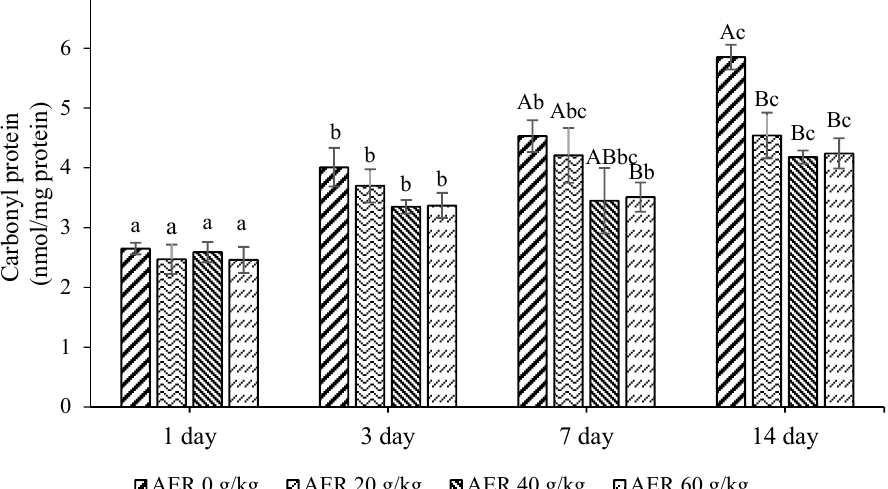
Figure 2. Protein carbonyl of LD from male dairy cattle with AER in TMR diet at different storage time. A–B Least square means with different letters within the same day of storage time are significantly different ( p < 0.05); a–c Least square means with different letters within the same treatments are significantly different ( p < 0.05); AER: anthocyanin extracted residue; LD: Longissimus dorsi ; TMR: total mixed ration.